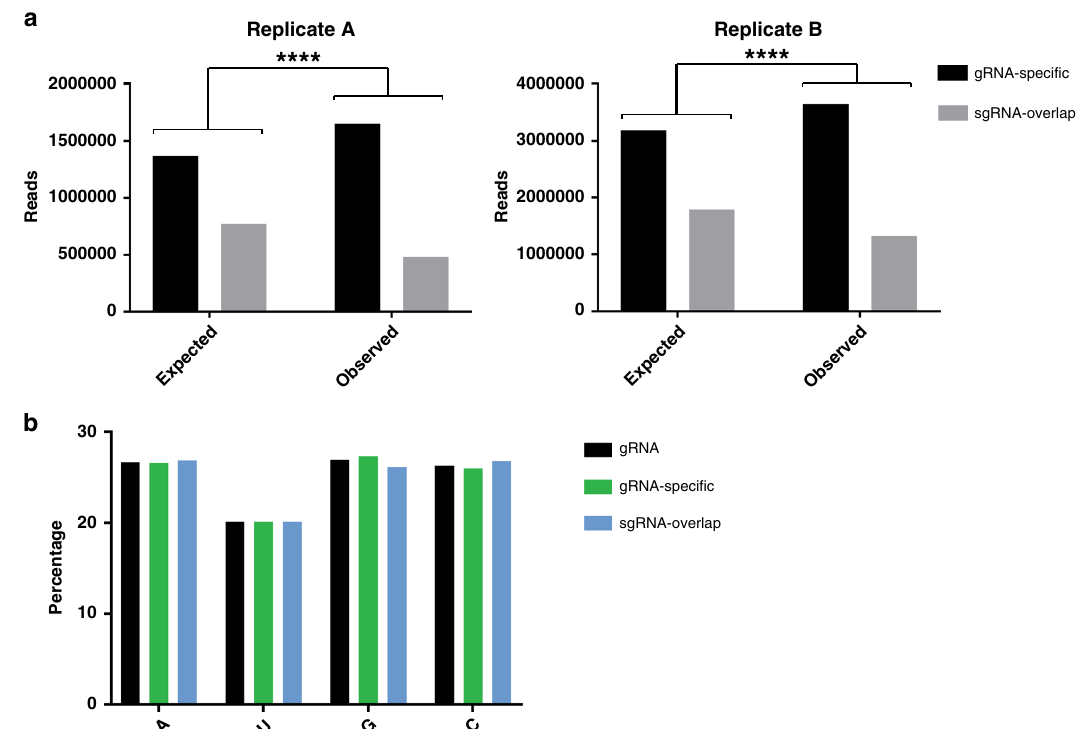
Fig. 3 Cp preferentially binds genome-speci fi c sequences. a χ 2 analysis test for biological replicate libraries ( a , b ) comparing the expected vs. observed number of sequence reads summed per nucleotide position mapping to gRNA-speci fi c sequences (black) or sequences that overlap with the sgRNA (gray). Two-sided, df = 1, **** p < 0.0001. b Nucleotide composition of the gRNA, gRNA-speci fi c sequences, and sequences that overlap with the sgRNA. See also Supplementary Data